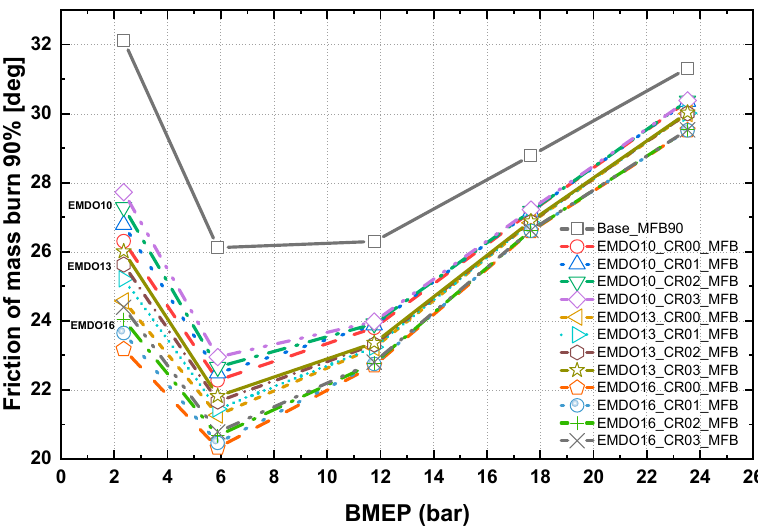
Figure 11. Characteristics of the friction at 90% mass burning versus three types of emulsified MDOs and four types of turbocharger nozzle rings.